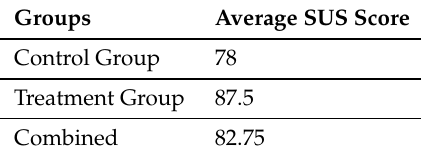
Table 3. SUS scores.